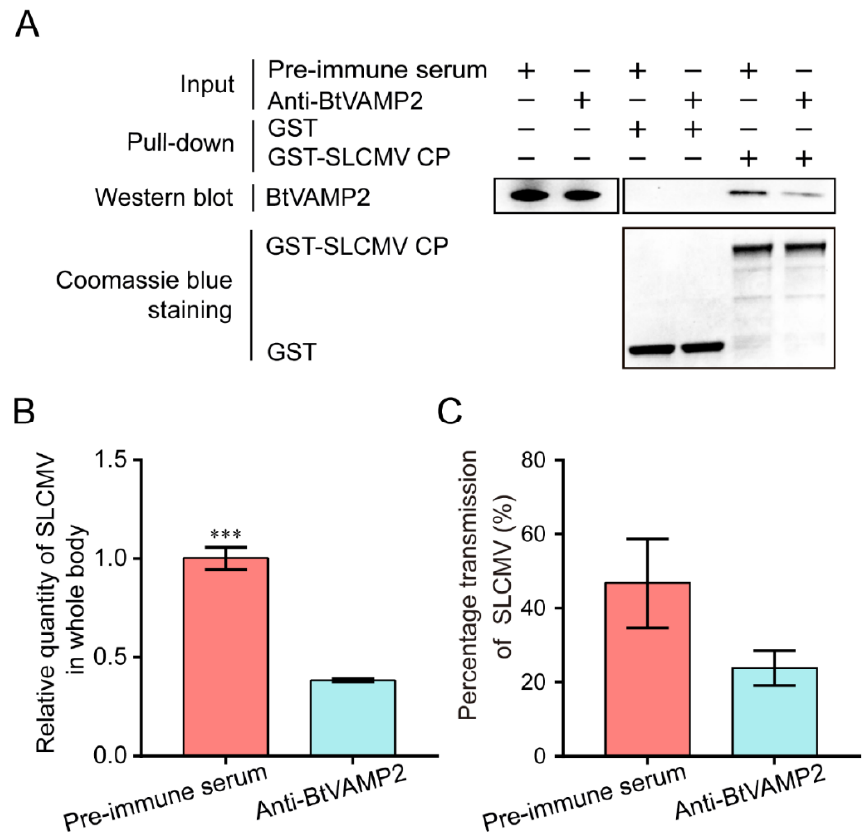
Figure 7. Analyses of the relative quantity of SLCMV in whitefly and the transmission efficiency of